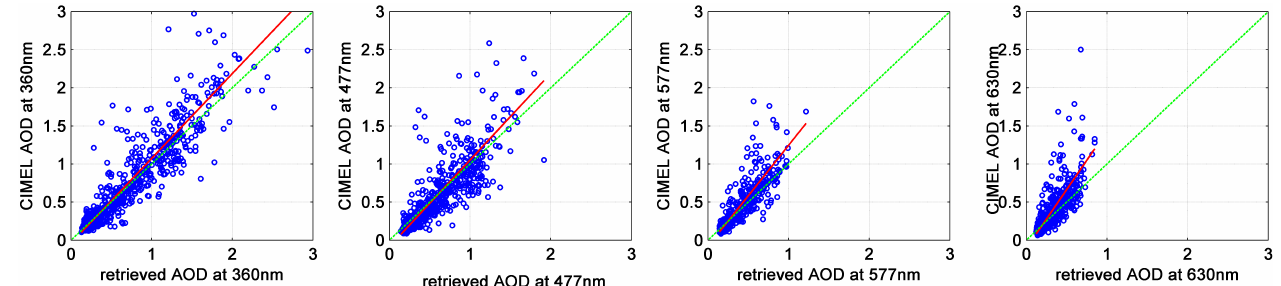
Fig. 14. Scatter plots of the total AODs at 360, 477, 577, and 630nm retrieved using the corrected O 4 DSCDs from the MAXDOAS measurements in Beijing versus the values from a co-located CIMEL instrument. Also shown are the linear regressions (red lines). Fit parameters and statistics are found in Table 2.